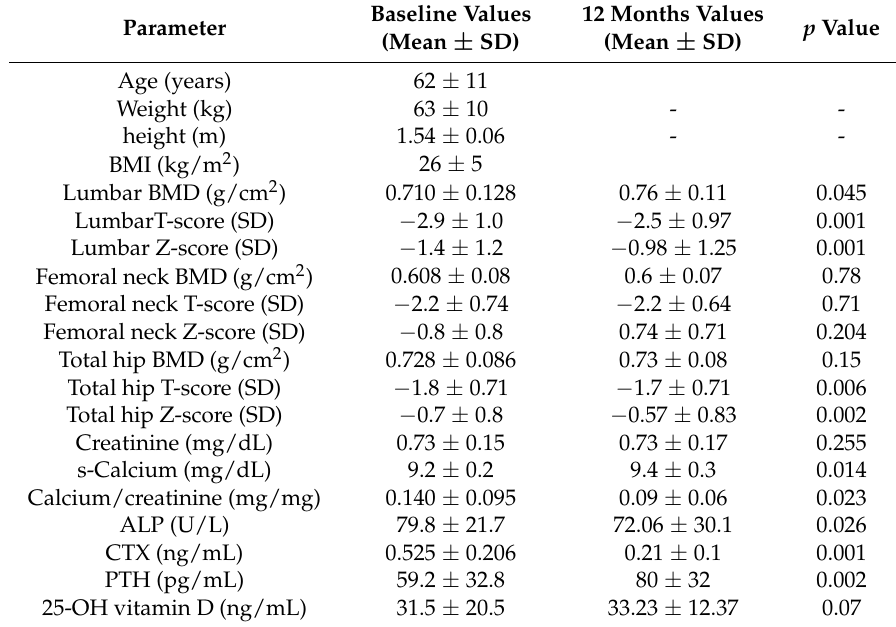
Figure 1. Schematic representation of the experimental design. Table 1. Anthropometric, densitometric, and biochemical data of the study population.